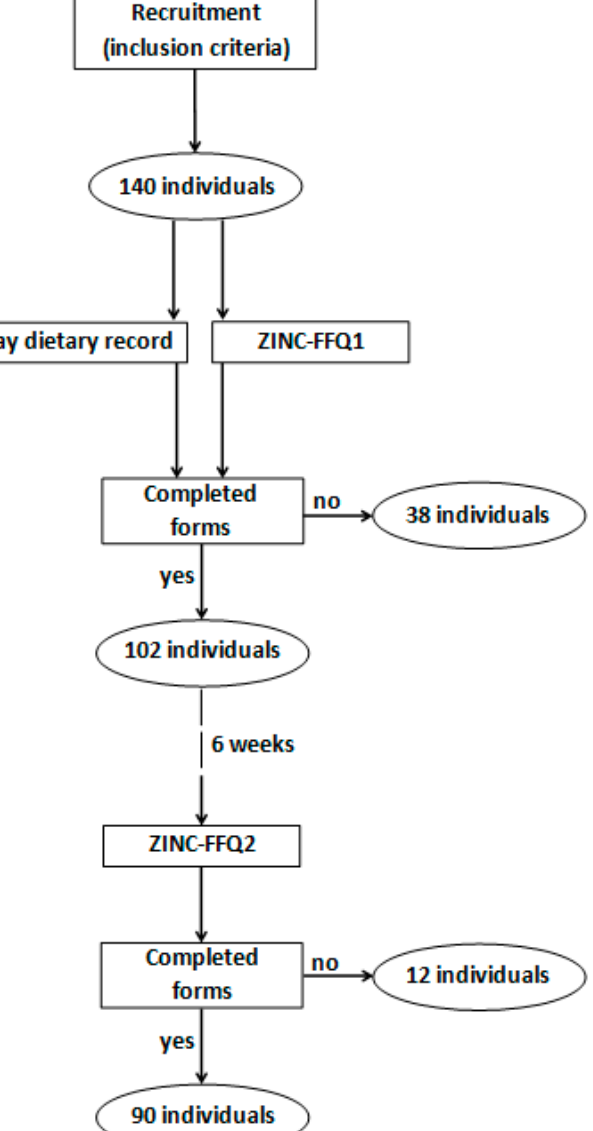
Figure 1. Participant recruitment to the validation of the questionnaire. ZINC-FFQ = Zinc INtake Calculation—Food Frequency Questionnaire.